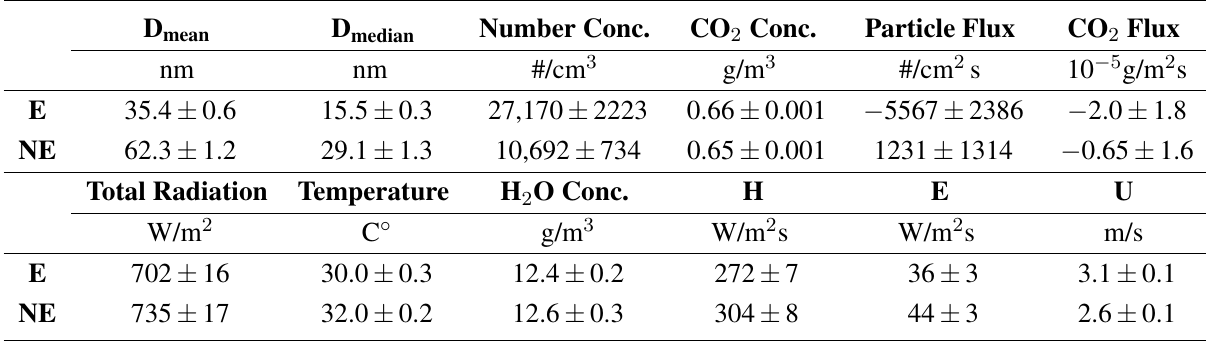
Table 2. Comparison of different average parameters calculated between 09:00 and 16:00 separately for event days and non-event days. The uncertainties are the standard errors. E, event day; NE, non-event day. Number